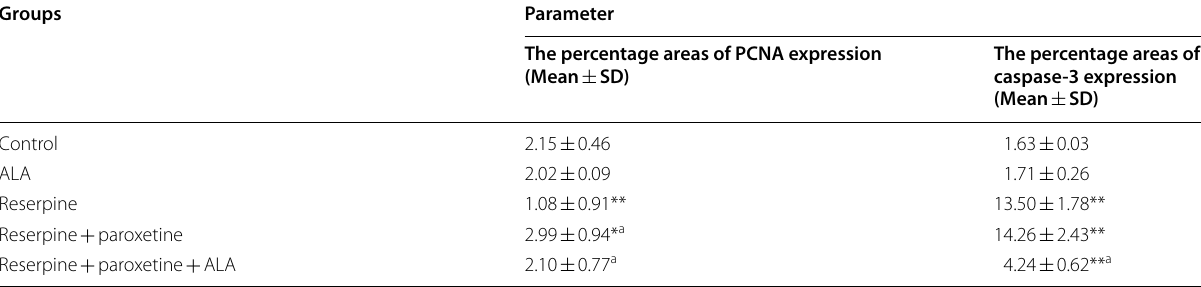
n 8 animals for each group =